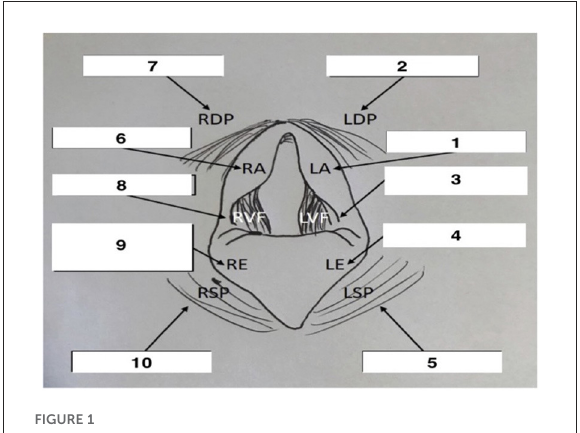
FIGURE1 Schematic representation of endoscopic view of the larynx with probe sequence. Adapted from Manneveau (19). Adapted with